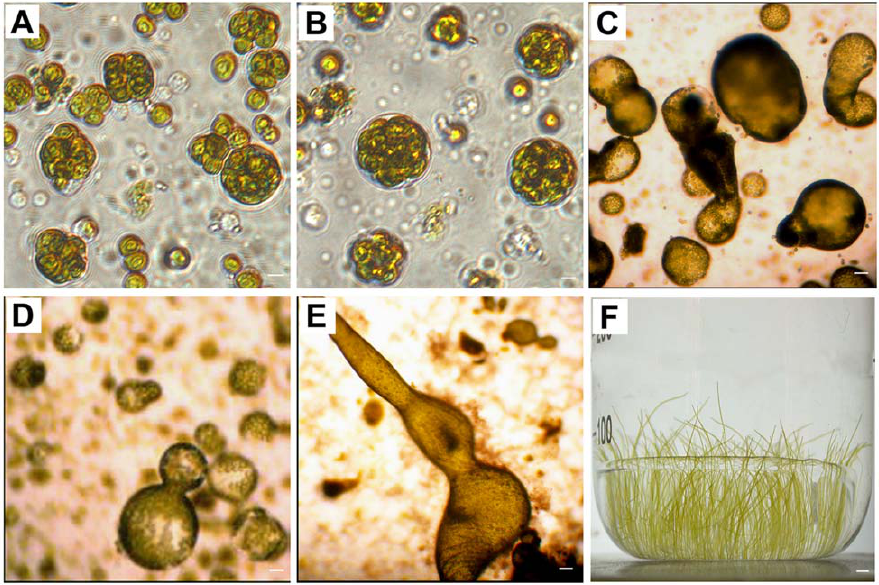
Figure 1. Formation and germination of protoplasts from B.hypnoides . A: formation of aggregation of protoplasts within 1 min; B: formation of a gelatinous envelope within 3 min; C–E: germination of the aggregation of B. hypnoides protoplasts; F: the germinated aggregation was developed into a mature individual. Bars, 10 m m (A–E), 1cm (F).